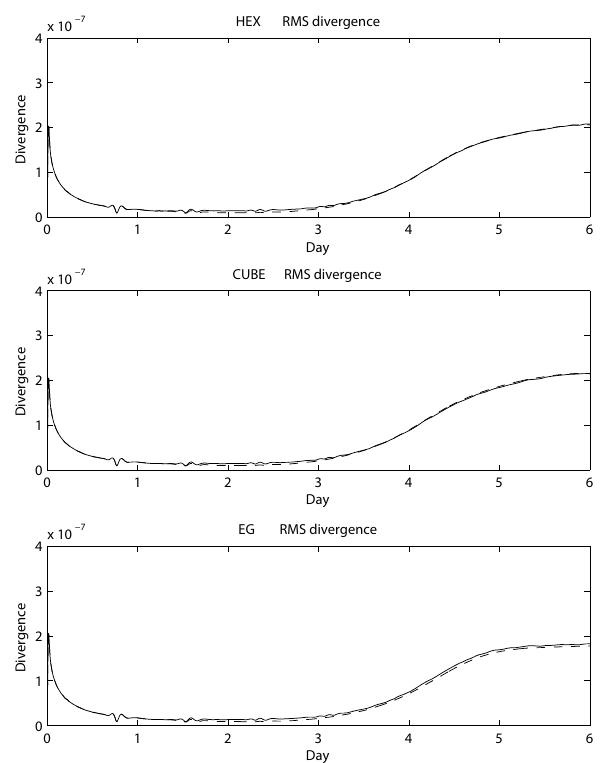
Figure 11. Time series of root-mean-square divergence. Top: hexagonal grid. Middle: cubed-sphere grid. Bottom: ENDGame. Dashed curves are for α = 1 . 0. Solid curves are for α = 1 . 0 for 500 steps then α = 0 . 5. The solid and dashed curves almost overlay each